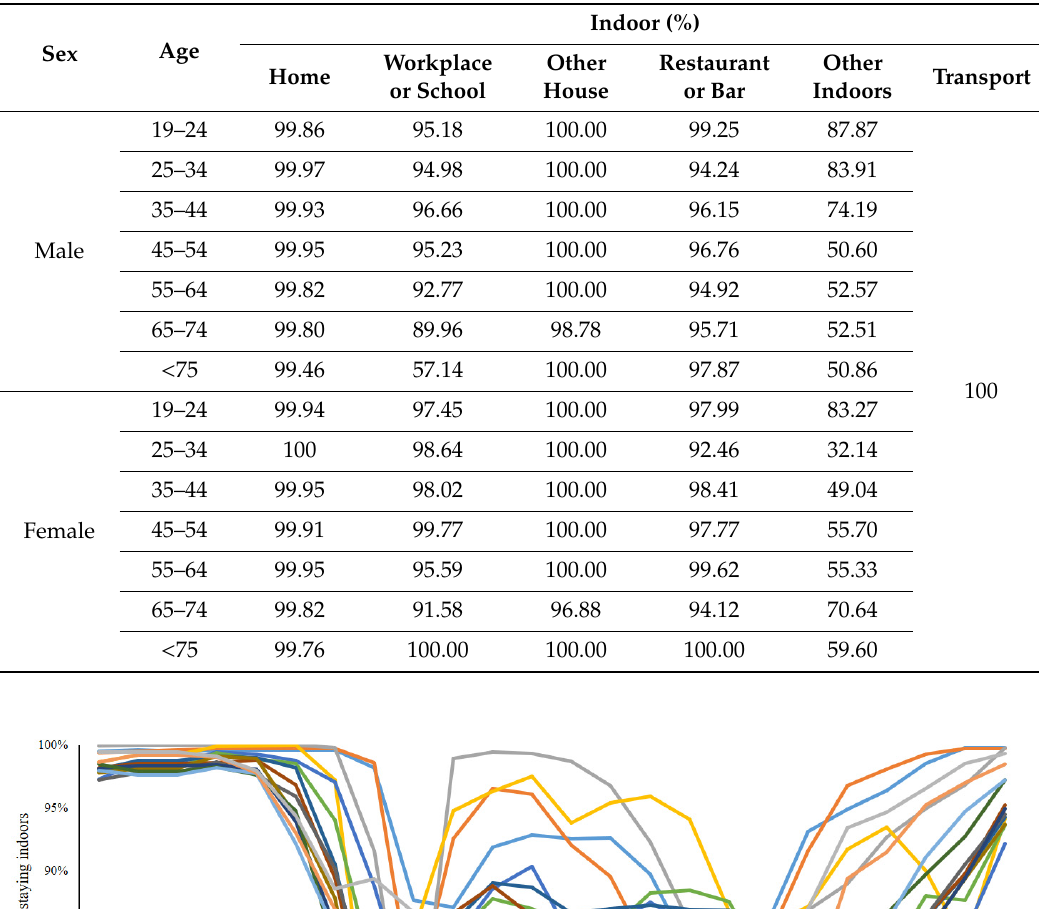
Table 1. Rate of staying indoors according to microenvironments by sex and age.